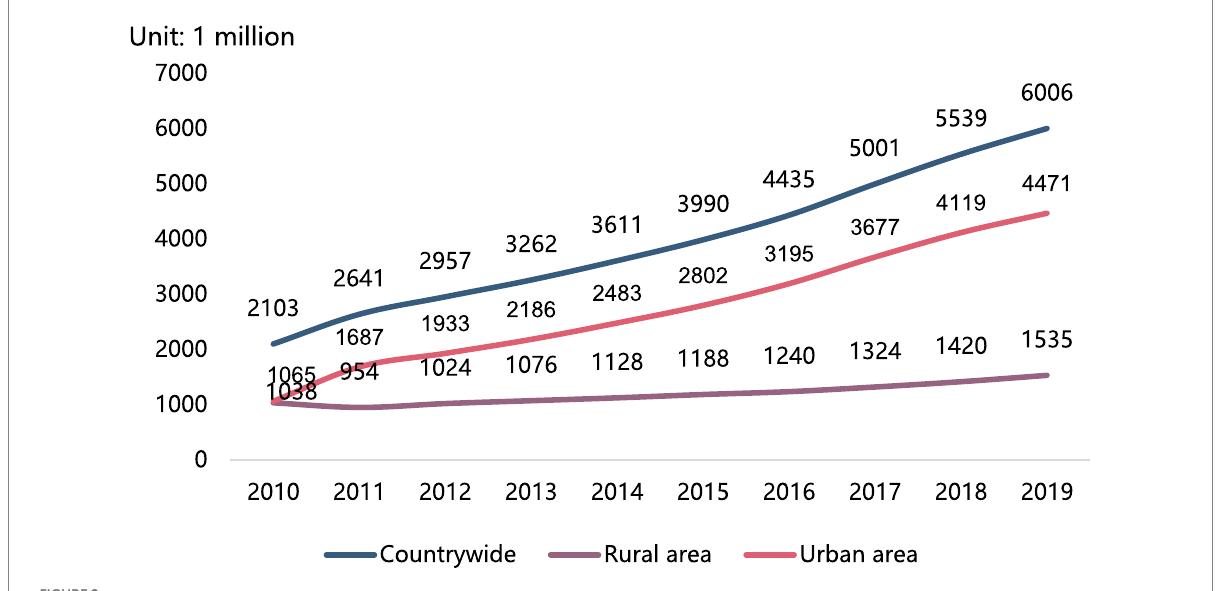
FIGURE 2 Domestic tourists in China. Data compiled by National Bureau of Statistics of China